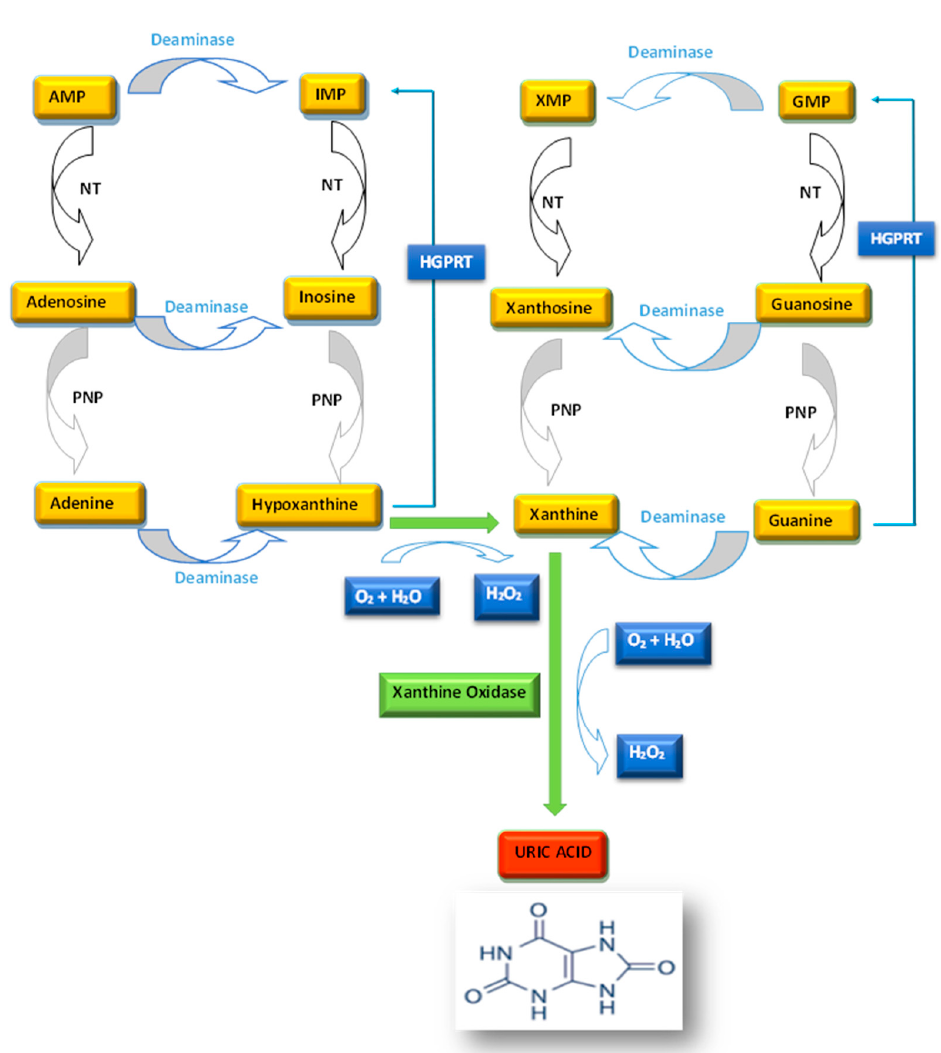
Figure 1. Biosynthesis of uric acid. AMP, adenosine monophosphate; GMP, guanine monophosphate; HGPRT, hypoxanthine-guanine phosphoribosyltransferase; IMP, inosine monophosphate; NT, 5 ′ -nucleotidase; PNP, purine nucleoside phosphorylase; XMP, xanthosine monophosphate.